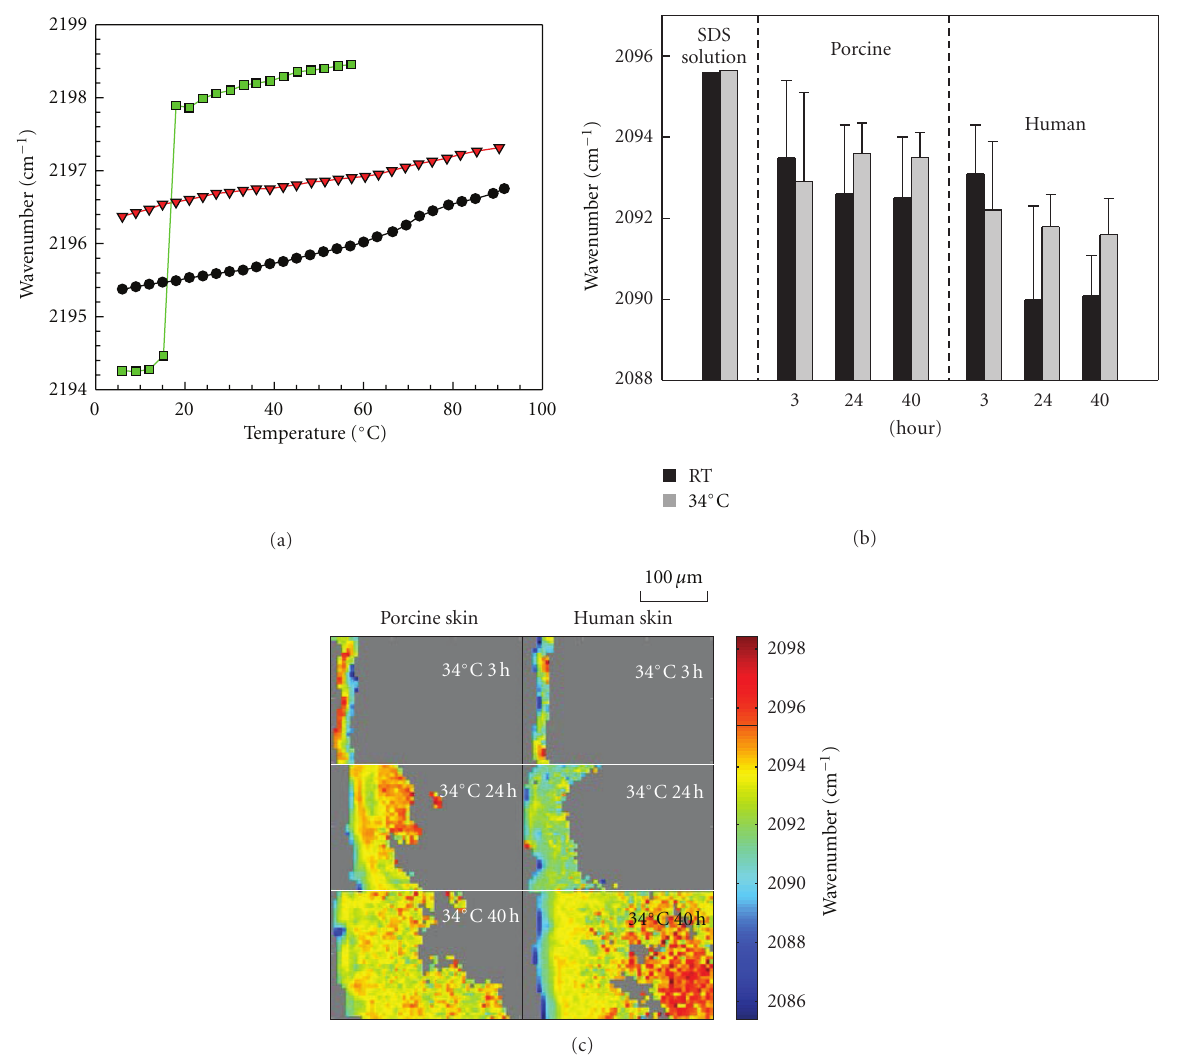
Figure 5: (a) Peak frequency of the SDS-d 25 CD 2 asymmetric stretching band as a function of temperature in isolated SC after 2h (circles line) and 6h (squares line) SDS-d 25 incubation along with a SDS-d 25 solution in PBS at 62.5 mg/mL (down-pointing triangles line); (b) average peak frequency of SDS-d 25 CD 2 symmetric stretching in porcine and human SC after 3, 24, and 40h treatment at room temperature (gray) and 34 ◦ C (black) along with a SDS-d 25 solution in PBS at 12.5 mg/mL. Error bars (standard deviation) do not reflect lack of precision in the measurement but rather predominantly arise from heterogeneity in the skin; (c) peak frequency of SDS-d 25 CD 2 symmetric stretching frequency in porcine and human skin after treatment for 3, 24, and 40h at 34 ◦